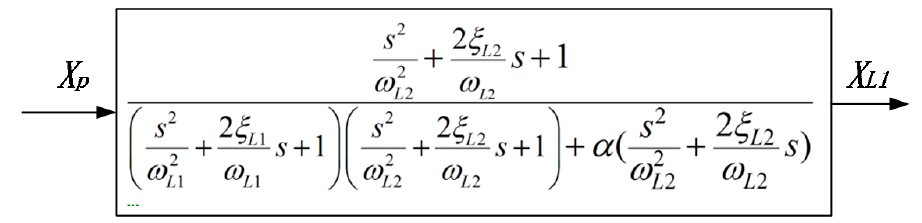
Figure 5. The control block diagram of the thrust vector dynamics.